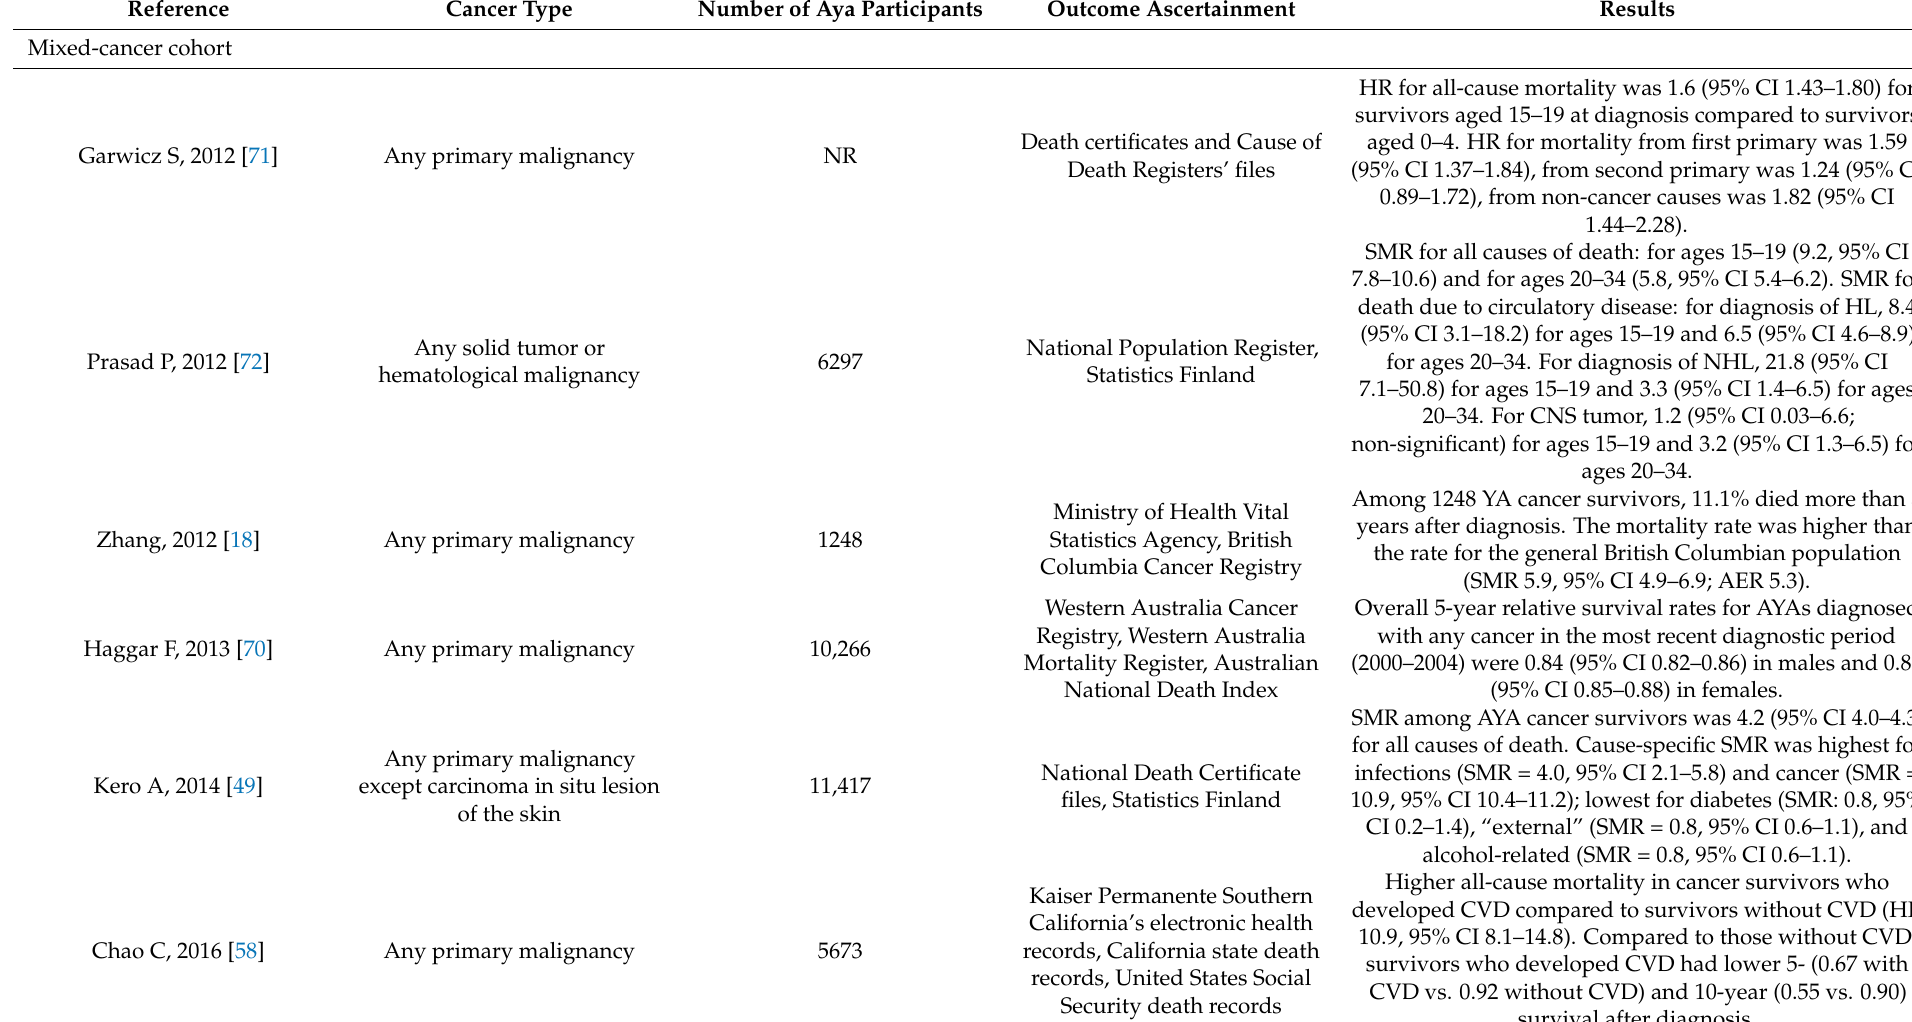
Table 3. The burden of late mortality among adolescent and young adult cancer survivors by tumor group (n =